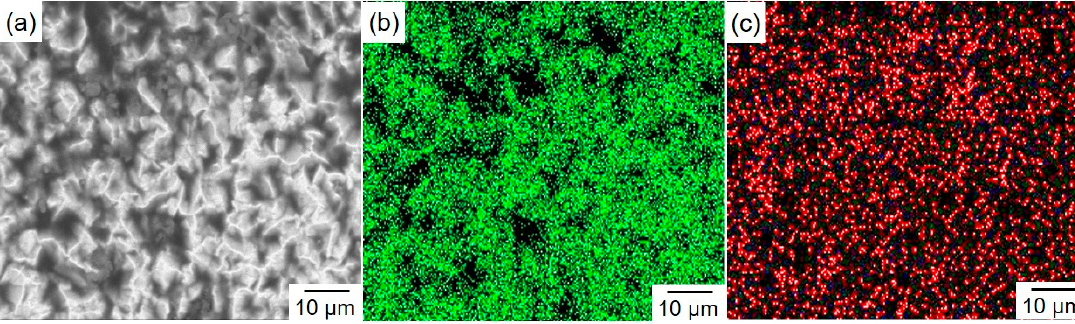
Figure 6. FE-SEM image of an electrodeposited Sn-15 at.%Zn alloy film ( a ). EDX elemental mapping images of Sn and Zn are also shown in ( b ) and ( c ), respectively.